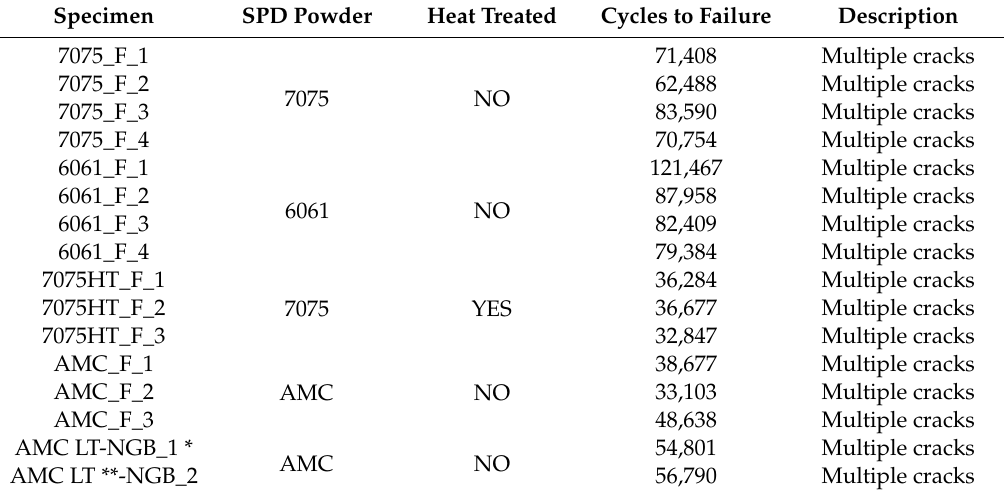
Table 1. Number of cycles to failure at 38.1 kN, and R = 0.1.